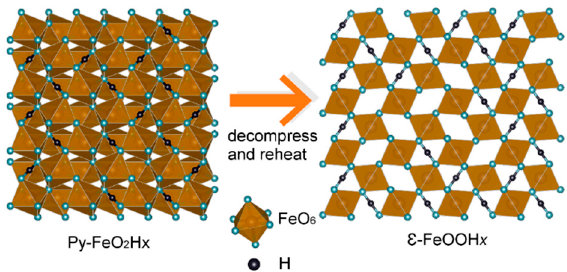
Table 3. Hydrogen content x in ε -FeOOH x .